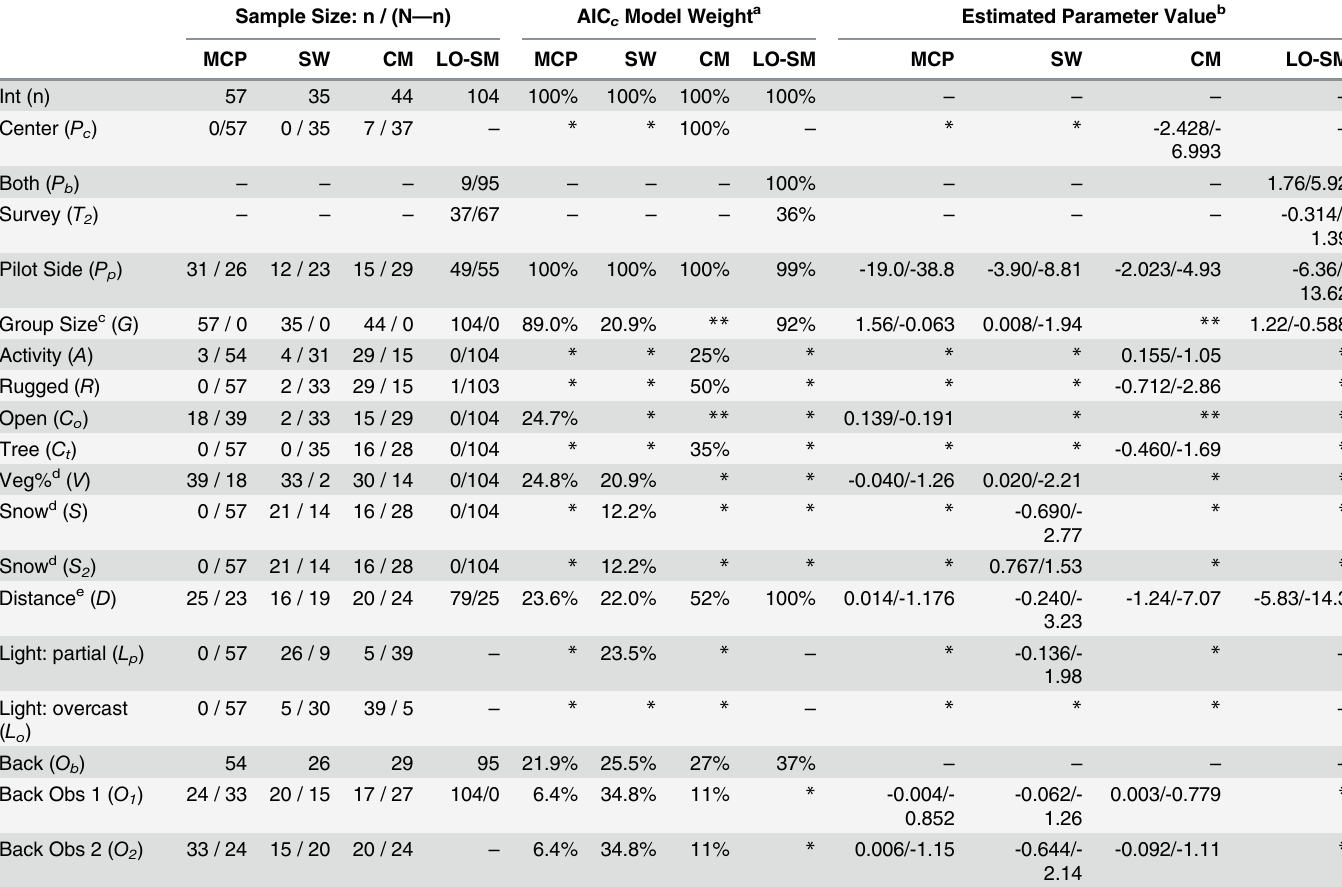
Table 3. Sample size, AIC c model support, and parameter estimates for models of feral horse ( Equus caballus ) abundance. U.S. Bureau of Land Management Herd Management Areas (HMA) Surveyed: McCullough Peaks HMA, Wyoming (MCP), Sand Wash HMA, Colorado (SW), Cedar Mountain HMA, Utah (CM), and removal at Little Owyhee-Snowstorm Mountains HMAs, Nevada (LO-SM), USA. Sample unit is horse groups, not individual horses. Sample Size: n / (N —